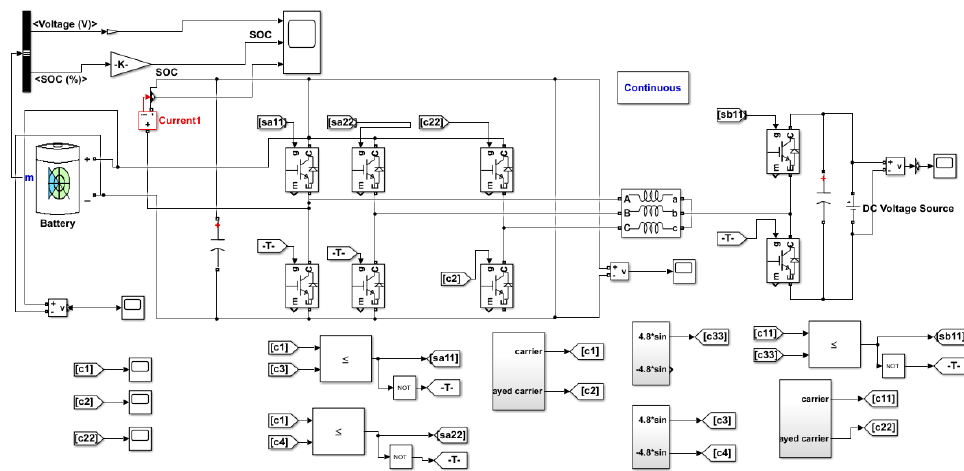
Figure 4. Simulink model for the NN – IPSO controller.